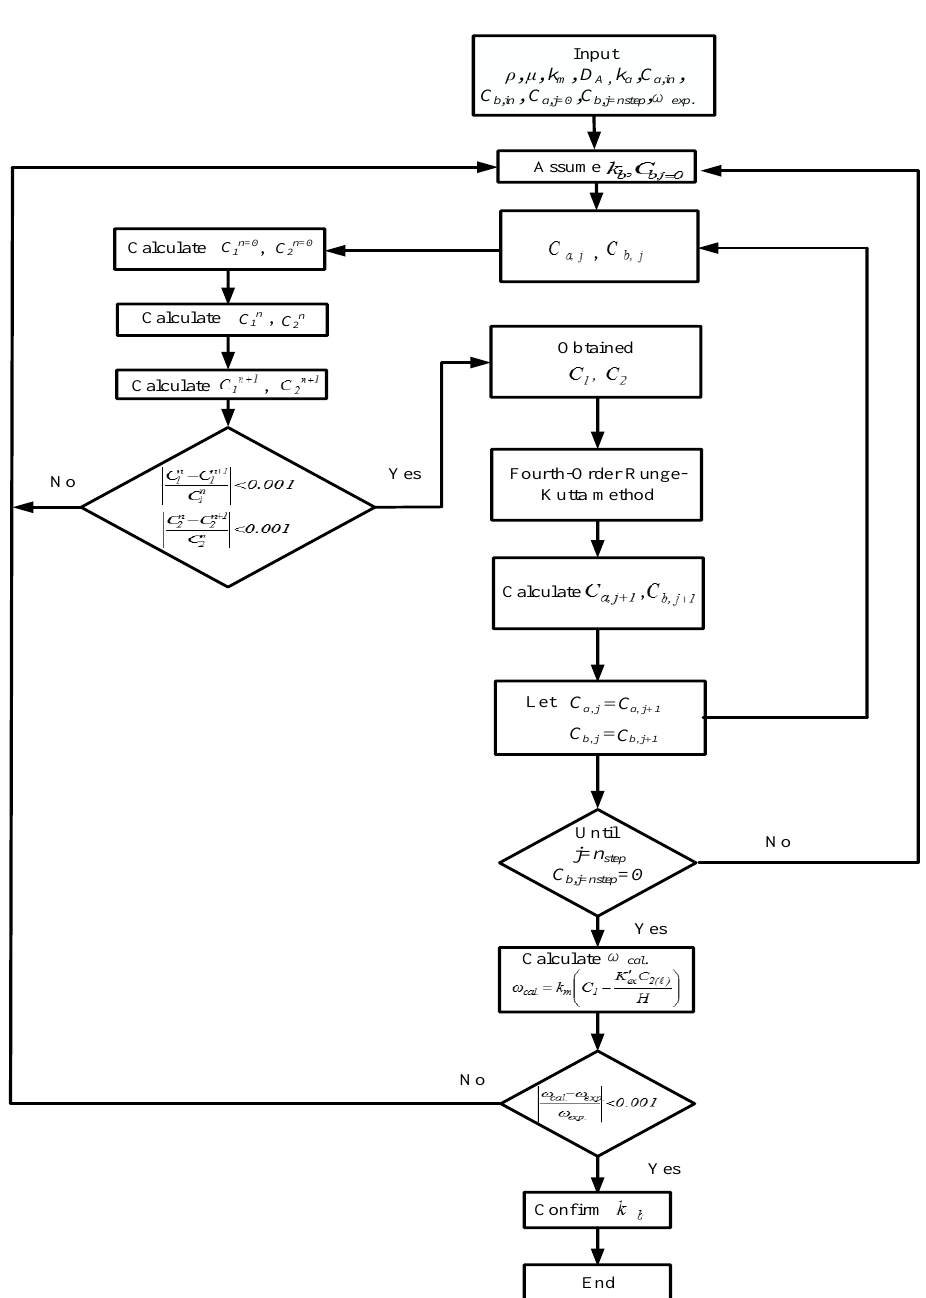
Figure 8. Calculation flow chart for determining CO 2 concentrations in gas and liquid phases under countercurrent-flow operations.